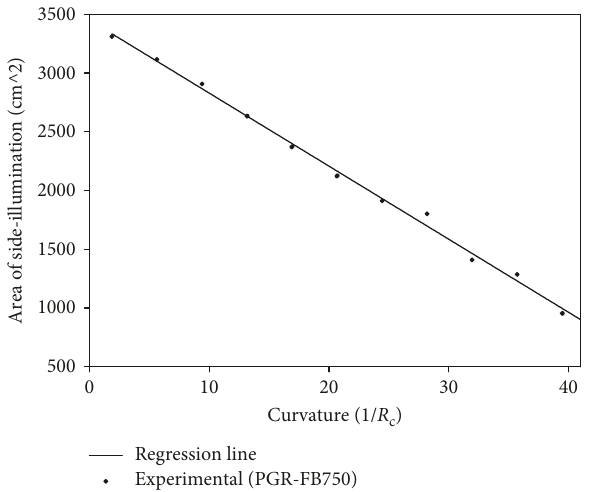
Figure 14: Effect of curvature on single POF side-illumination area.